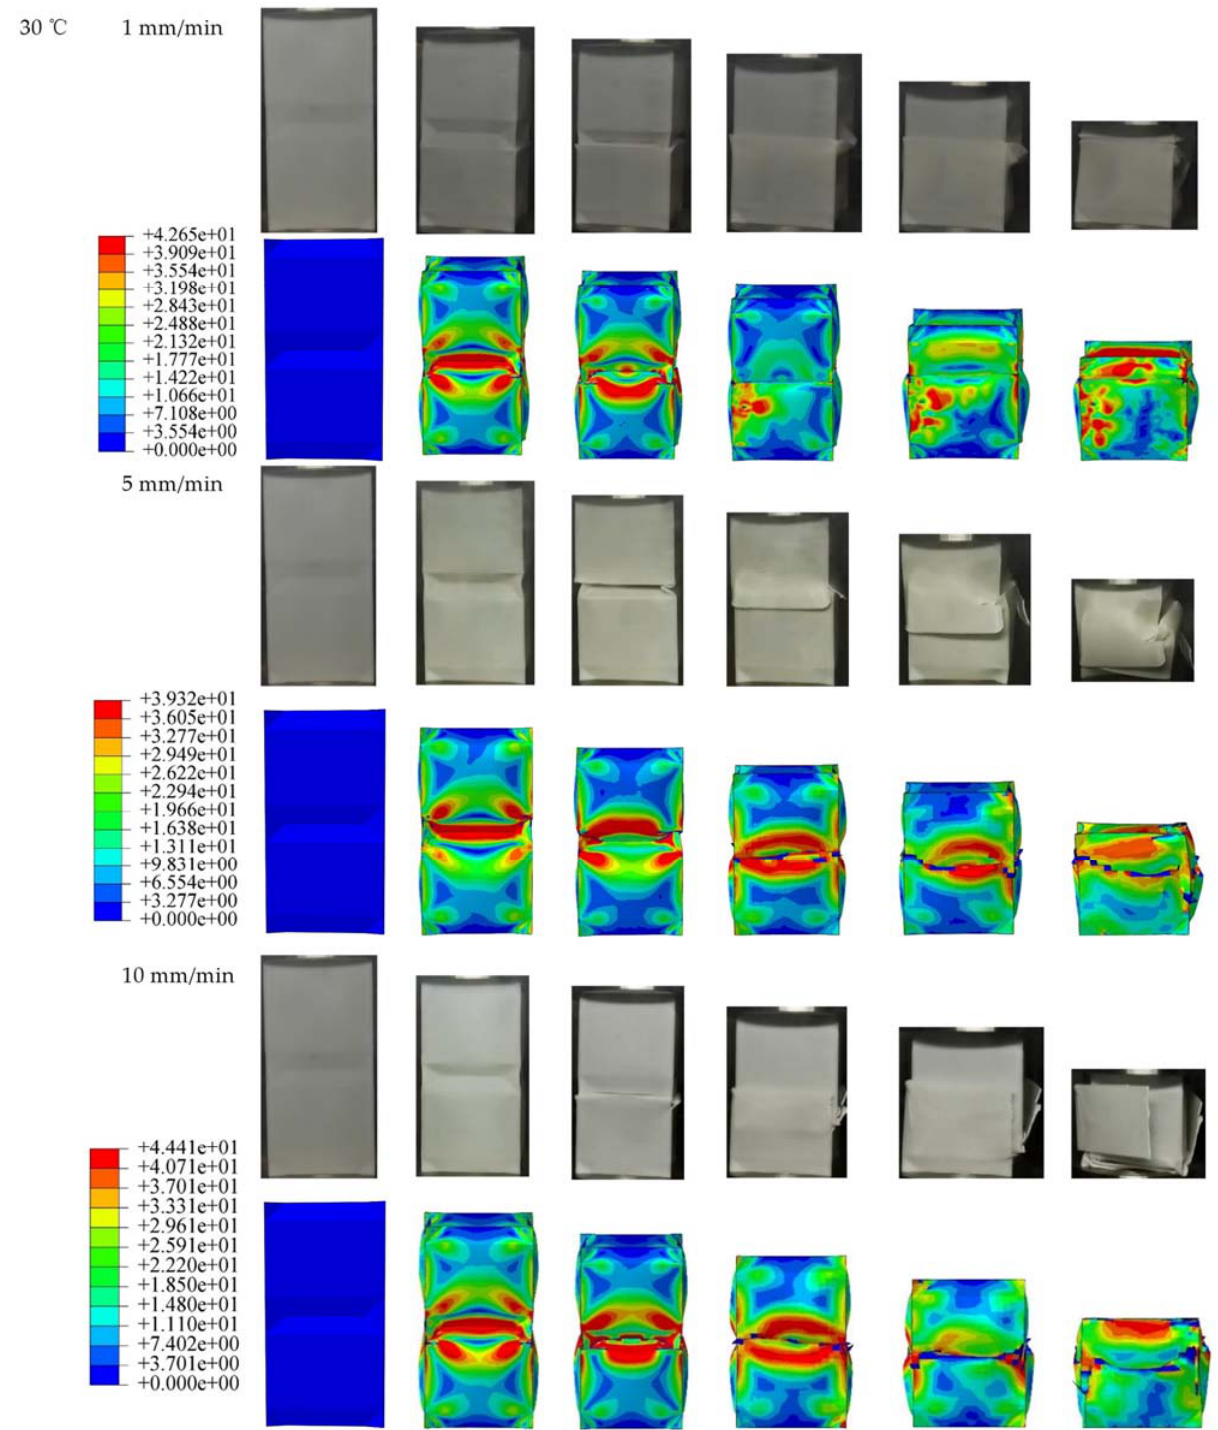
Figure 6. Experiment and simulation of deformation process of OET.